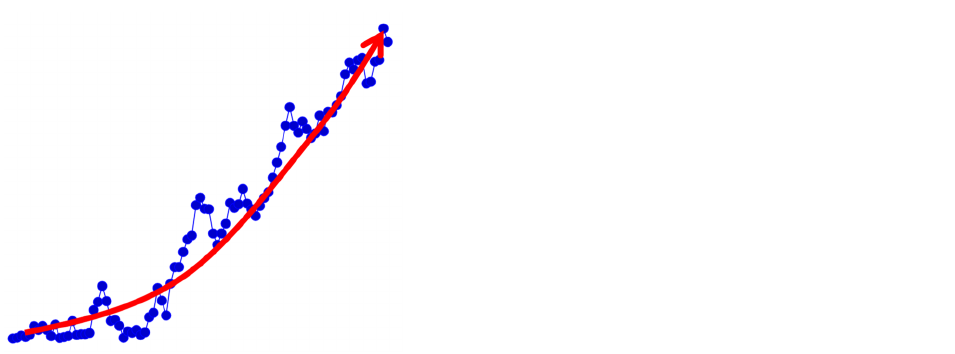
Figure 25. Figure with arrow indicating the high growth rate of the error in a single agent pose estimation. Firgures 26 and 27 show a single LiDAR agent.